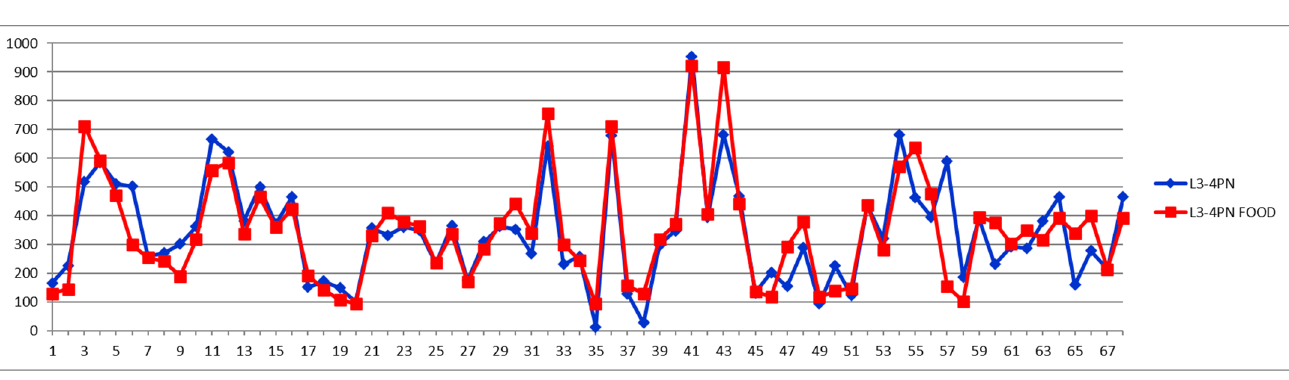
Figure 6. Large LDL particle number (L1PN + L2PN) (nmol/L) in fasting (blue) and postprandial (red) status for control cases (1–29) and CVD cases (30–68).